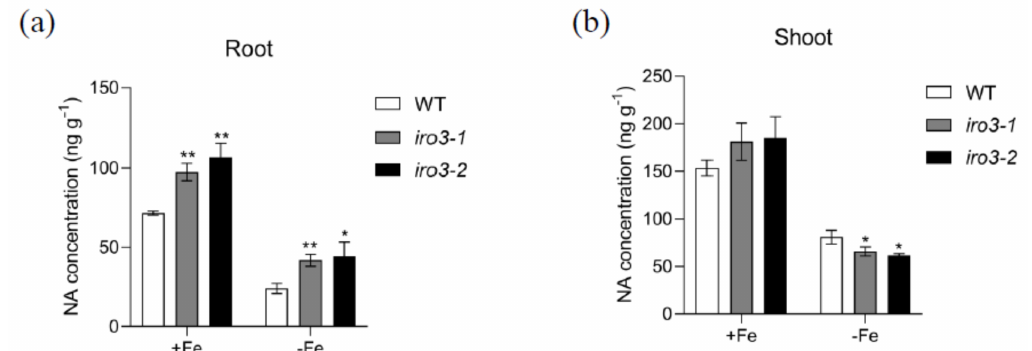
Figure 7. Nicotianamine (NA) concentration in WT and iro3 mutants. ( a ) Root NA concentration of WT and iro3 mutants under + Fe and − Fe conditions. ( b ) Shoot NA concentration of WT and iro3 mutants under + Fe and –Fe conditions. Two-week-old seedlings were transferred to Fe-deficient conditions ( − Fe) and Fe-su ffi cient conditions ( + Fe) for 4 d. Root and shoot samples were harvested and NA concentrations were measured according to the method described in the Materials and Methods section. Data are given as the means ± SD of three biological replicates. All data were compared with the WT. Significant di ff erences from the wild type are indicated by * p < 0.05, ** p < 0.01, as determined by two-tailed Student’s t